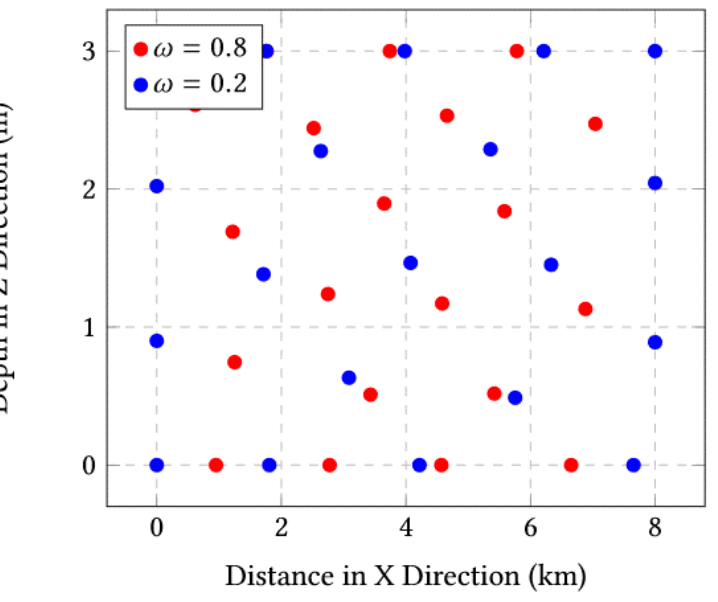
Figure 8. Final positions for ω = 0.8 and ω = 0.2 for the case of 20